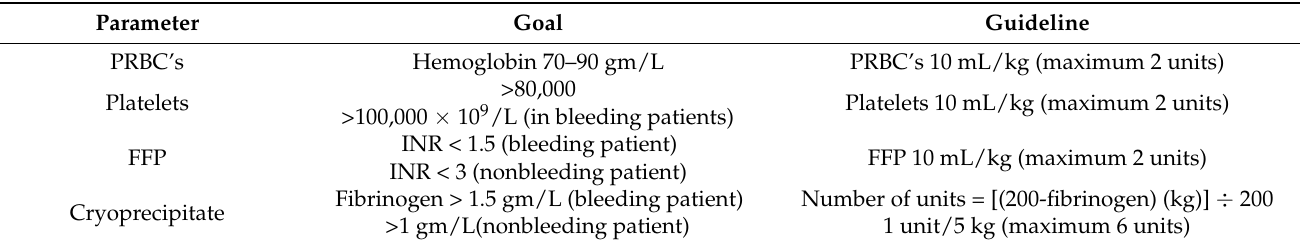
Table 5. Blood product transfusion guidelines during extracorporeal membrane oxygenation